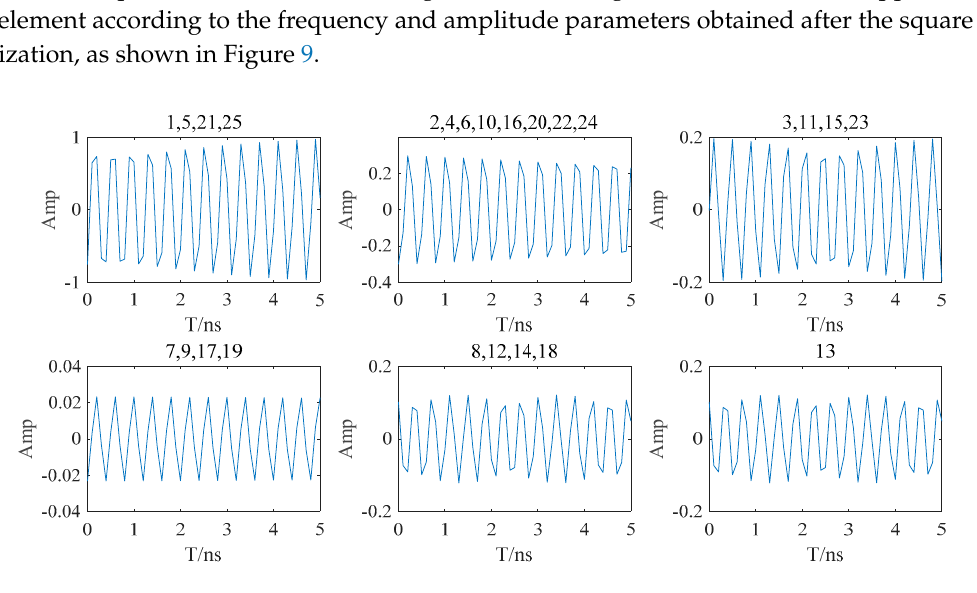
Figure 9. Excitation signals of the elements.